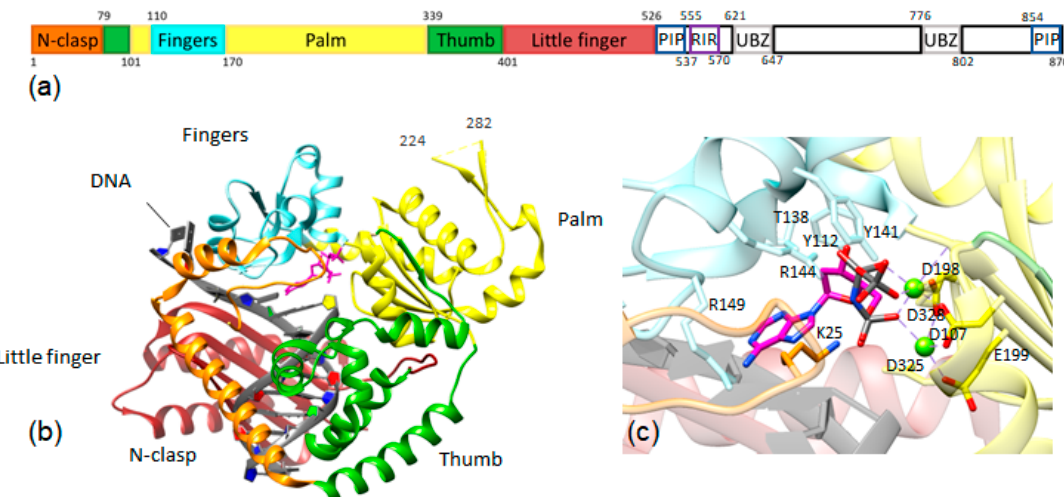
Figure 2. ( a ) Diagram of the domains of human pol κ : In addition to the polymerase domains, PCNA-interacting peptide (PIP) regions, Rev1-interacting region (RIR), and ubiquitin-binding zinc finger (UBZ) domains are shown. ( b ) The structure of the polymerase domain of human pol κ with domains colored as in Figure 2a (PDB ID: 6CST) [23]. ( c ) Close-up view of the structure of pol κ highlighting the active site residues in contact with the incoming nucleotide. The catalytic residues D107, D198, and E199 are shown in yellow sticks with red oxygen atoms; others are shown as sticks colored by the domain as in Figure 2a,b. Metal ions are shown as green spheres.